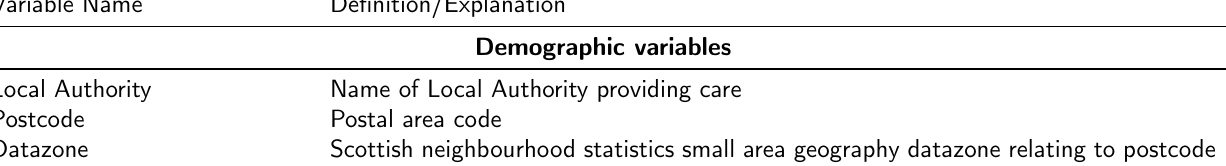
Table 2: Summary of variables available from SCS